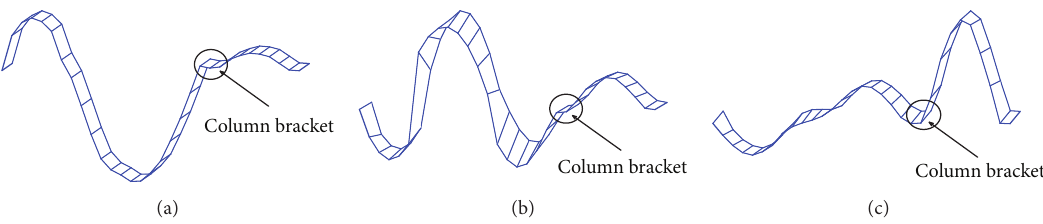
Figure 7: First three modes of the bridge. (a) 1 st vertical bending, f � 1.68Hz. f v, 3